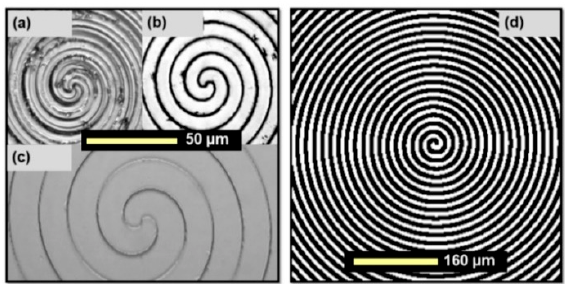
Figure 3. Parts of selected spiral phase gratings (SPGs) used as vortex beam shapers in the experimental studies: ( a – c ) fixed diffractive elements (left) and ( d ) spiral structure programmed into the SLM grey scale map (right). The elements correspond to configurations 3, 4, 6, and 2 in Table 1, respectively.